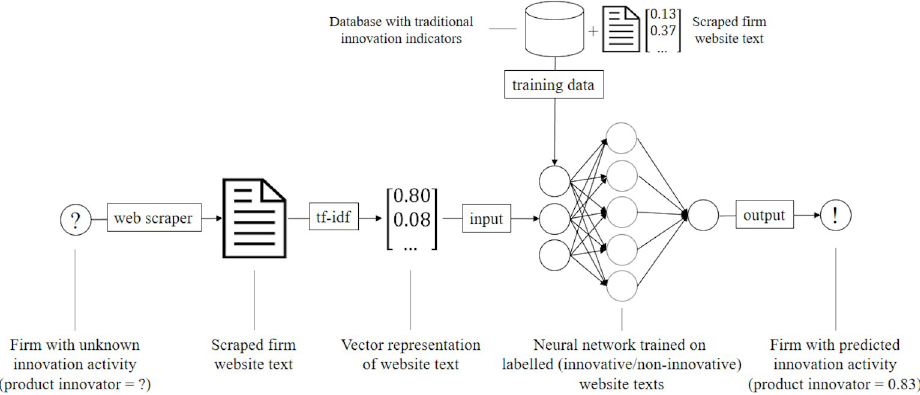
Fig 1. Proposed product innovator prediction framework. Web scraped texts from firms with a known innovation status are used to train a artificial neural network. The trained model can then be used to predict the innovation status of out-of-sample (unlabelled) firms based on their website